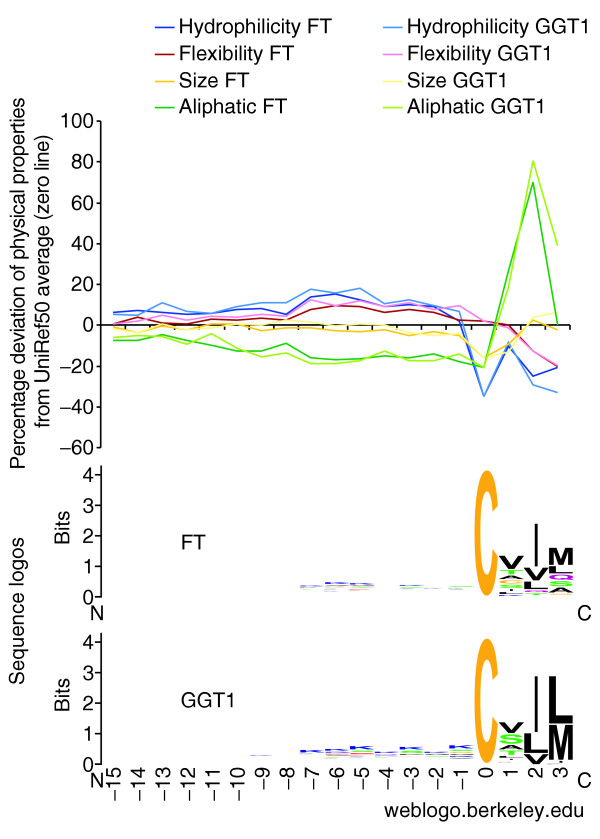
Sequence logos [74] and physicochemical property profiles of FT and GGT1 substrates. Selected physical properties (hydrophilicity = KRIW790102; flexibility = KARP850103, size = CHOC760101; aliphatic = ZVEL_ALI_1; see Tables 1 and 2 for details) are calculated as average over the nonredundant learning sets of FT and GGT1. The plotted lines correspond to the relative deviation of the respective properties from an average calculated over carboxy termini from the UniRef50 database [22].